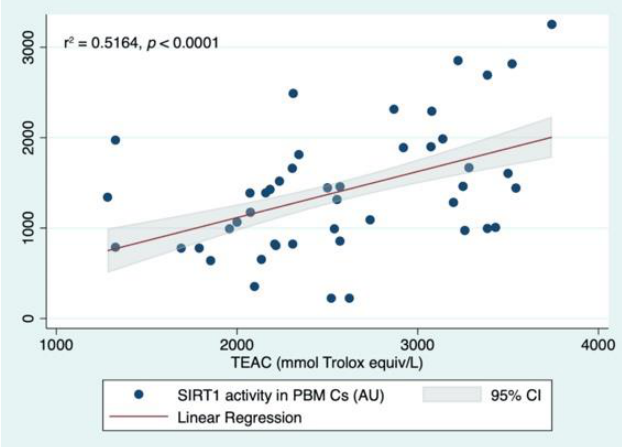
Figure 3. Linear regression analyses with SIRT1 (SIRT1) activity measured in peripheral blood mononuclear cells (PBMCs) and Trolox equivalent antioxidant capacity (TEAC) measured in serum.